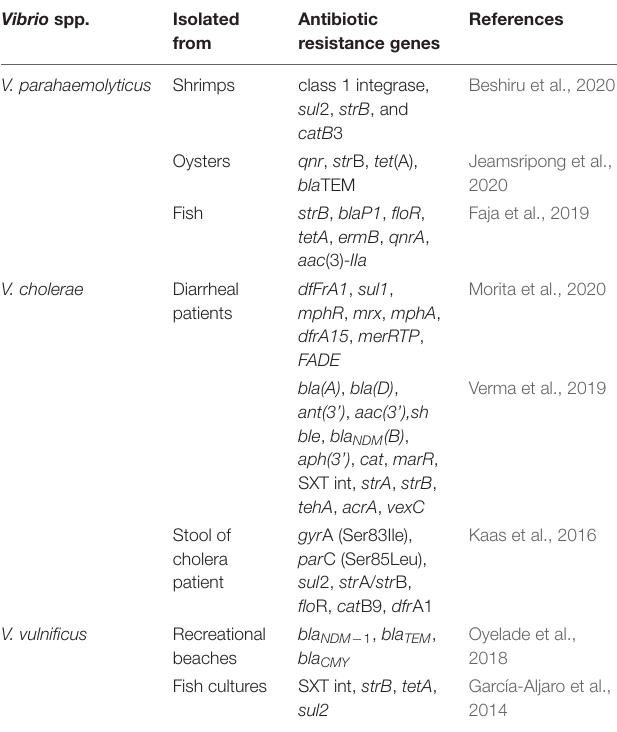
TABLE 1 | Presence of antibiotic resistance genes in different Vibrio spp. Vibrio